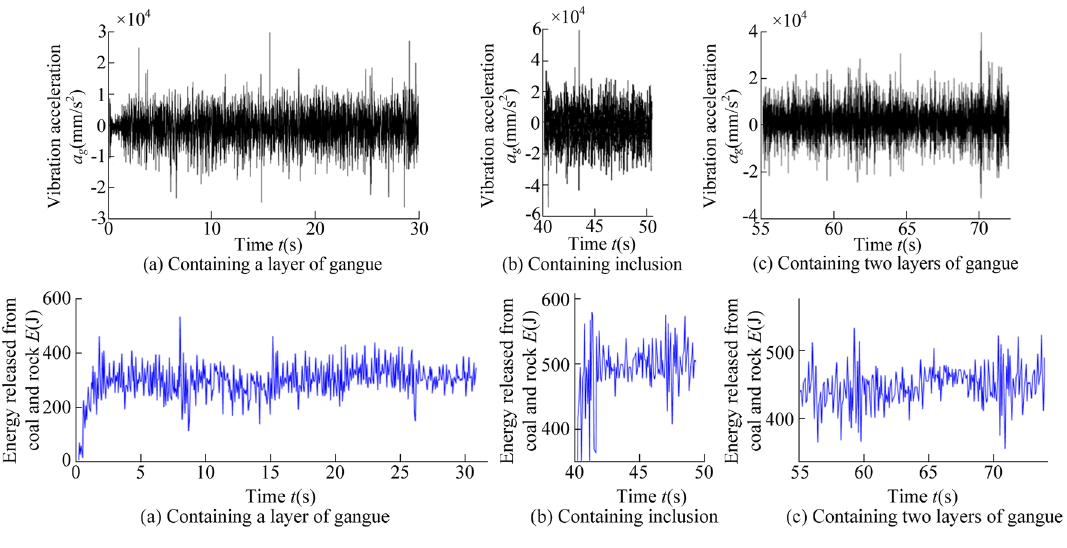
Figure 21. Experimental